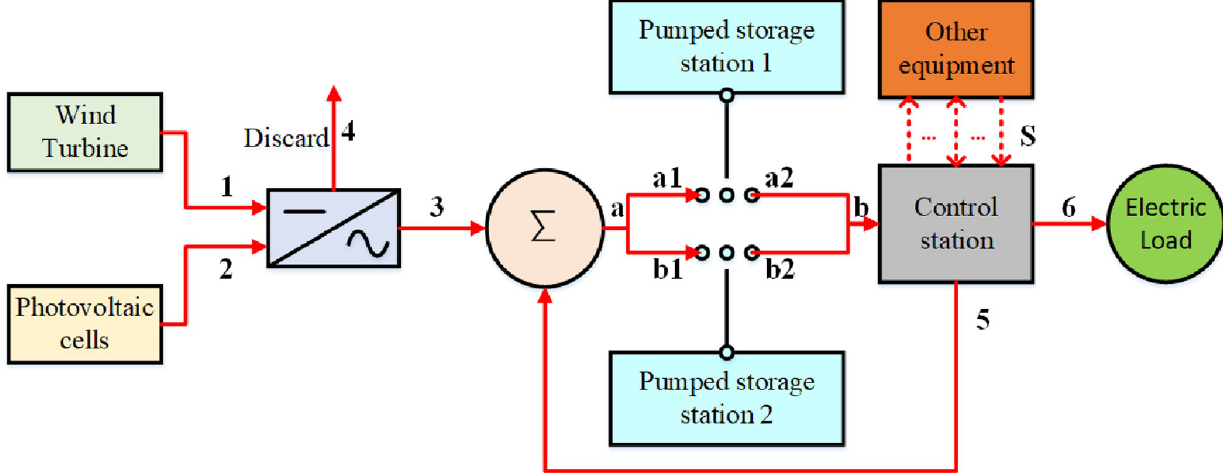
Fig 1. Wind-solar-pump storage energy supply